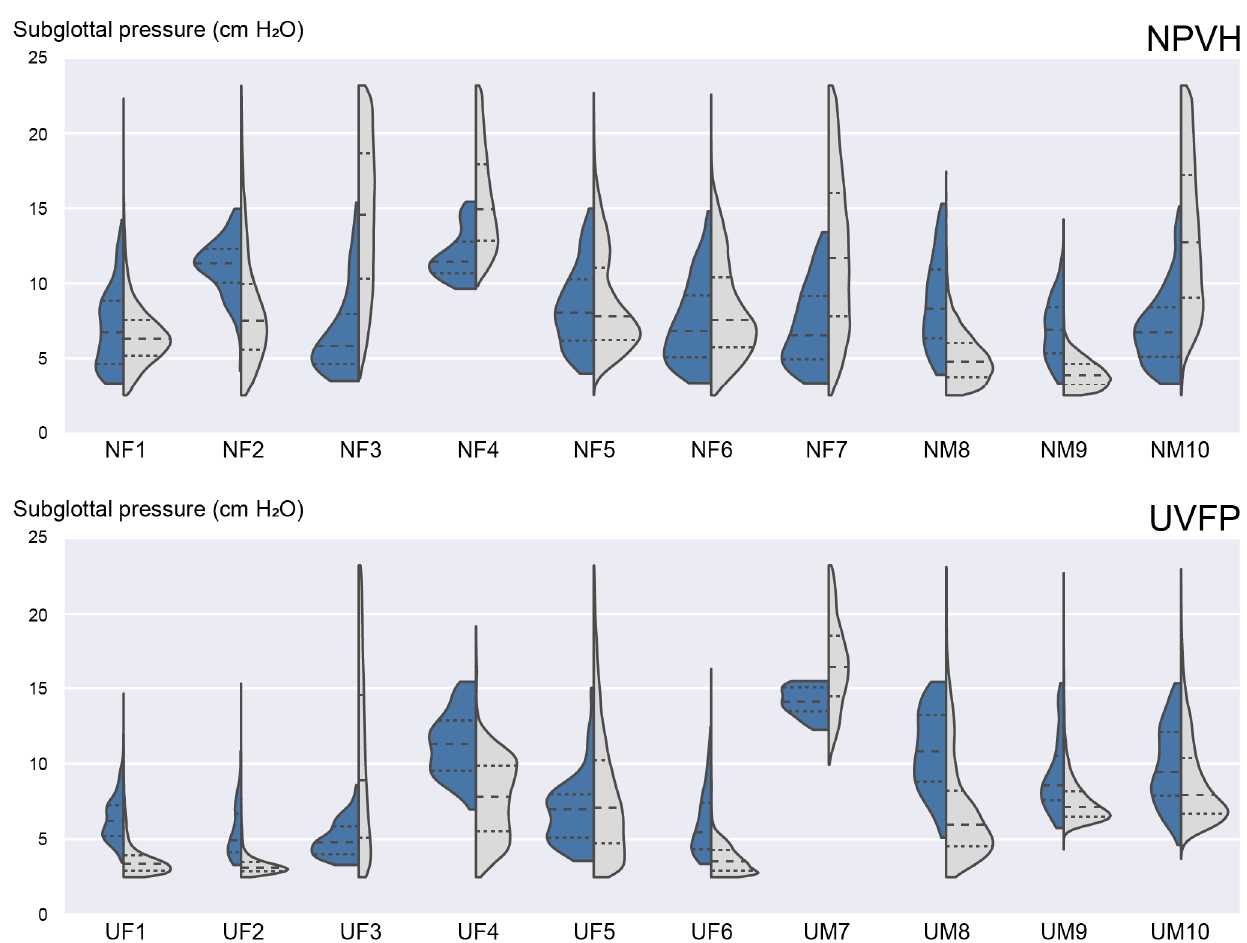
Figure A1. Split-violin plots comparing laboratory (left distribution) and ambulatory (right distribution) estimates of Ps for each patient.